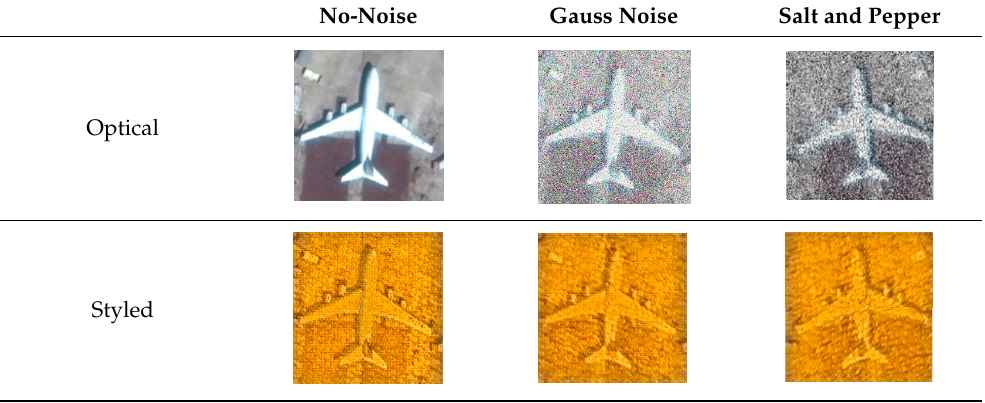
Table 10. Detection result for 3 types of noise. Model